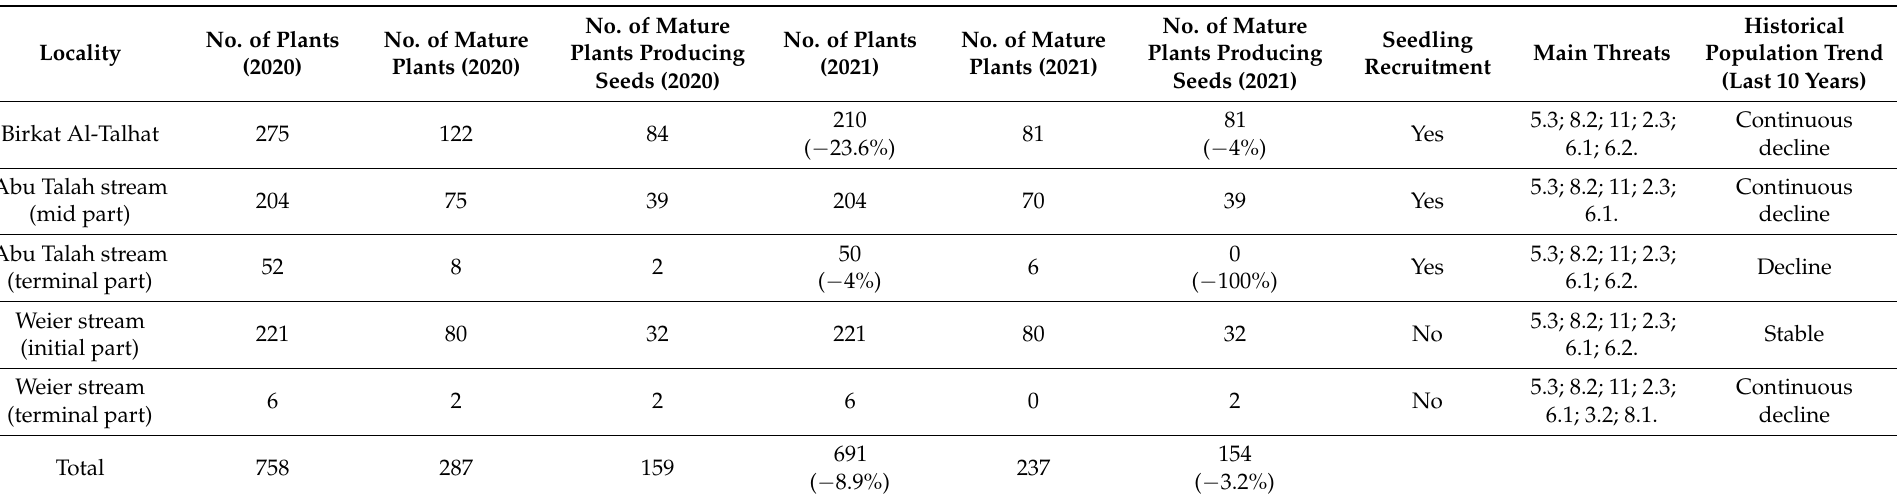
Table 1. Characteristics of the five known subpopulations of Vachellia gerrardii subsp. negevensis in Iraq. The major threats are reported according to their importance, starting with the most impacting, and are indicated according to the following IUCN codes [42]: 2.3 = Nomadic grazing; 3.2 = Mining and quarrying activities; 5.3 = Logging and wood harvesting; 6.1 = Recreational activities; 6.2 = Military exercises; 8.1 = Invasive non-native/alien species; 8.2 = Problematic species, pests; 11 = Climate